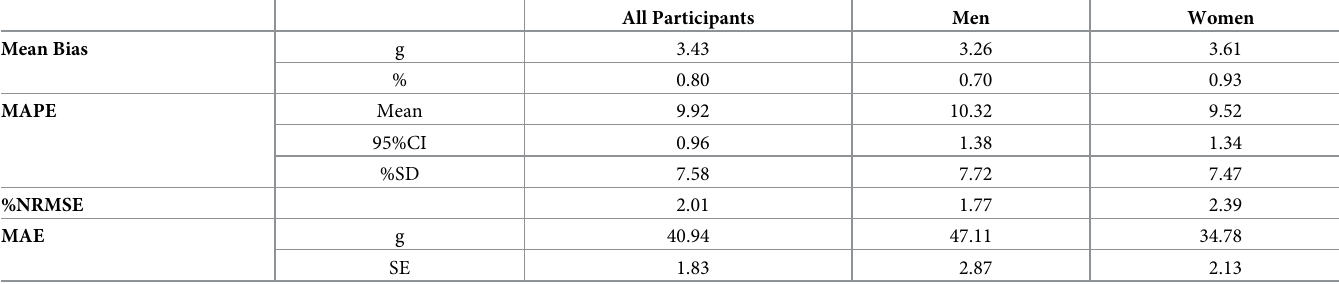
Table 2. Summary of statistical comparisons between DBM Samsung Gear Fit2 and the mass loss measurement standard method.